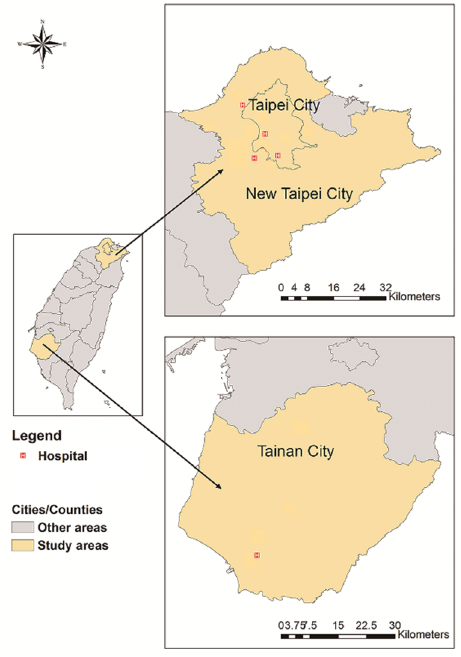
Figure 2. Locations of participating